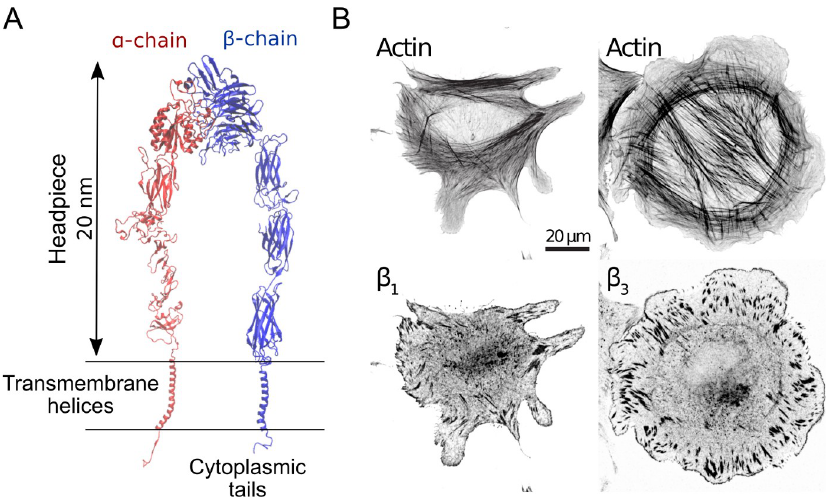
Fig 1. Both β -1 and β -3 integrins localize at the cell periphery, where nascent adhesions assemble. (A) Cartoon representation of active, fully extended α IIB β 3 integrin, which is closely related to α v β 3 [82]. (B) Representative images of human foreskin fibroblasts (HFF) fixed after 60 minutes of spreading on fibronectin coated glass coverslips and immunostained for actin and either β -1 or β -3 integrins.